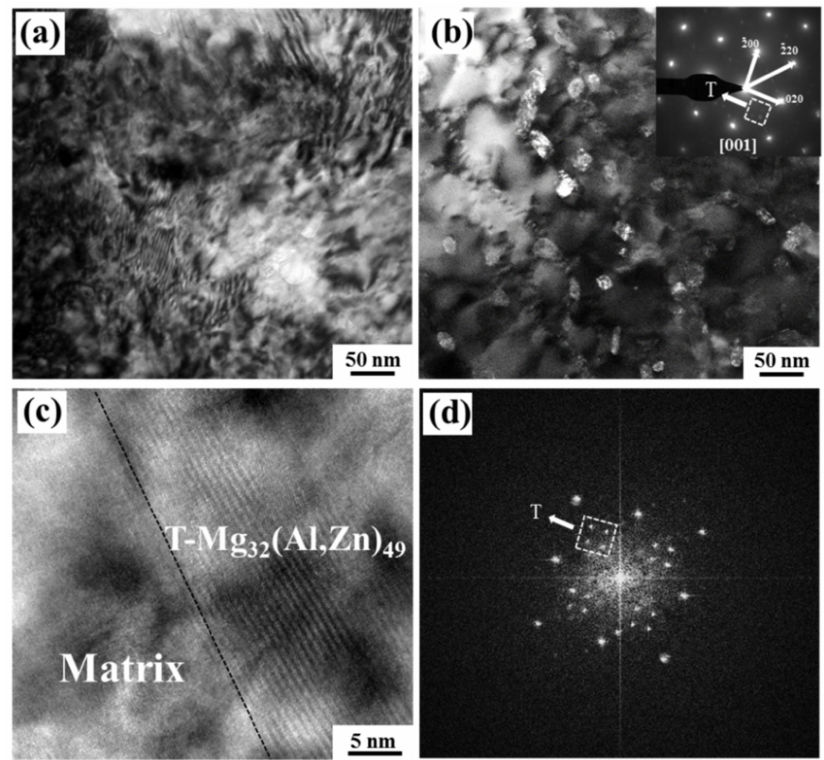
Figure 3. TEM microstructure of 150 ◦ C-annealed alloy: ( a ) BF TEM image, ( b ) DF TEM image and corresponding SAED pattern, ( c ) HRTEM image, ( d ) FFT image corresponding to ( c ).